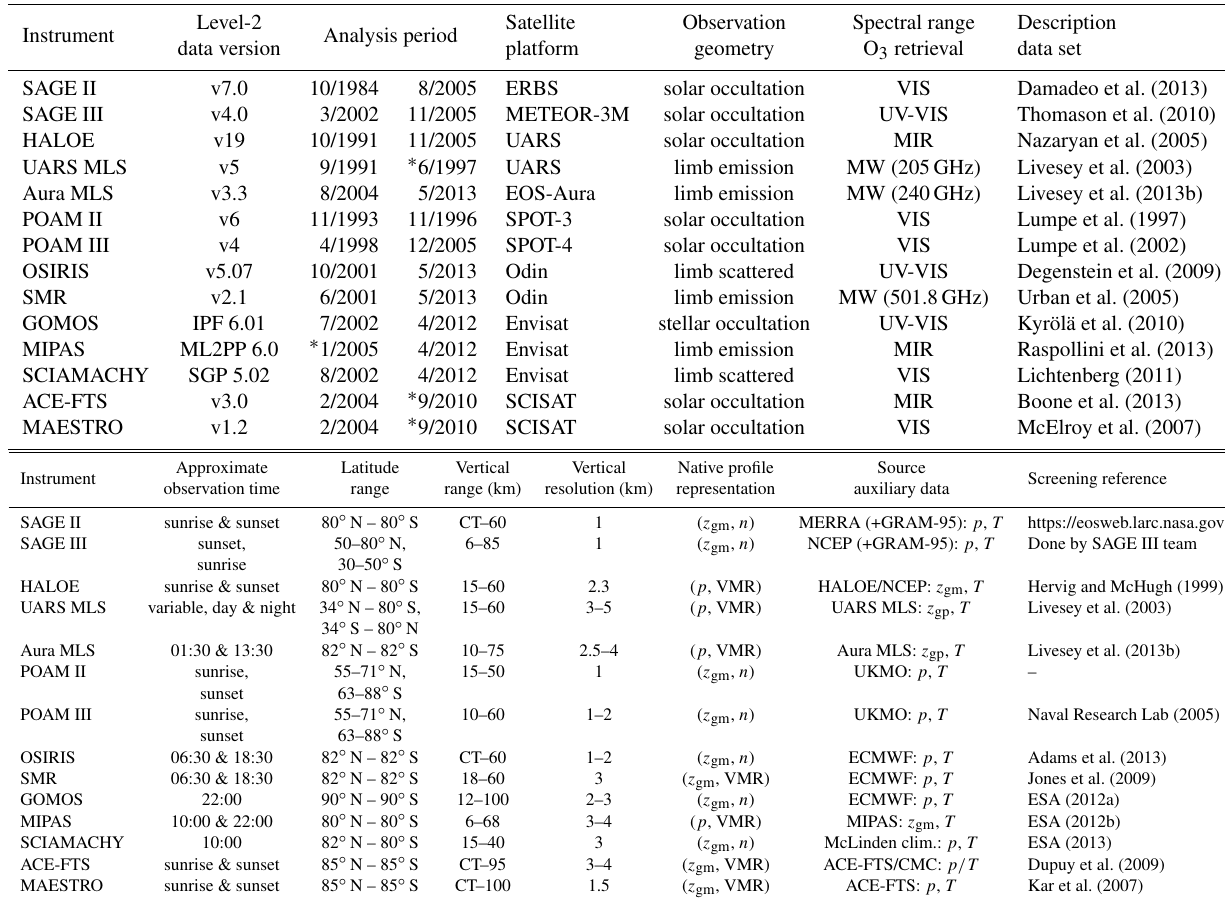
Table 3. Overview of satellite ozone profile data records. For more details on the instrument and the retrieval technique we refer to the review by Hassler et al. (2014). Some instrument teams recommend to discard a considerable part of their ozone record for long-term studies. The asterisk in the analysis period columns denotes whether the early or late part of the mission is cropped (see